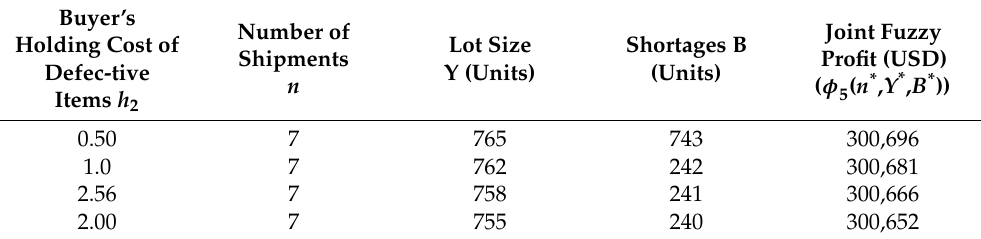
Table 10. Impact of the buyer’s holding cost of the defective items on the decision variables and joint fuzzy profit.